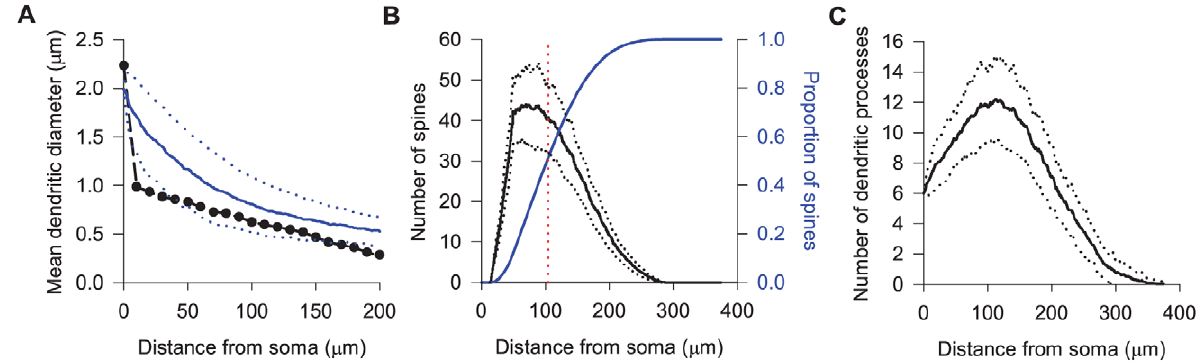
Figure 5. Predictions of the MSN dendrite models. A The diameters of MSN dendrites as a function of the distance from the soma ( . ; data supplied by C. Wilson), and the mean diameters predicted by the dendrite model with the parameters from the evolutionary algorithm search. The data mostly fall within one standard deviation of the model’s mean values. (The diameters were averaged over all instantiated dendrograms; the dashed lines indicate + 1 s.d. from the mean). B Predicted distribution of spines across the dendrites of one MSN (histogram of the mean number of spines per m m step away from the soma in black, with + 1 s.d. plotted as dotted lines; cumulative distribution of spines given by the blue solid line). The dendrite models predict that the mean total number of spines per MSN is * 5934 , with half occurring within 103 m m of the soma (indicated by the horizontal red dotted line). C The mean number of dendritic processes for an MSN per m m step away from the soma (solid line; dotted lines plot + 1 s.d.); given the known relationship between spine density and distance from the soma (Figure 4B, equation 6), the fall of the number of processes able to support spines dictates the spine distribution shown in panel B.